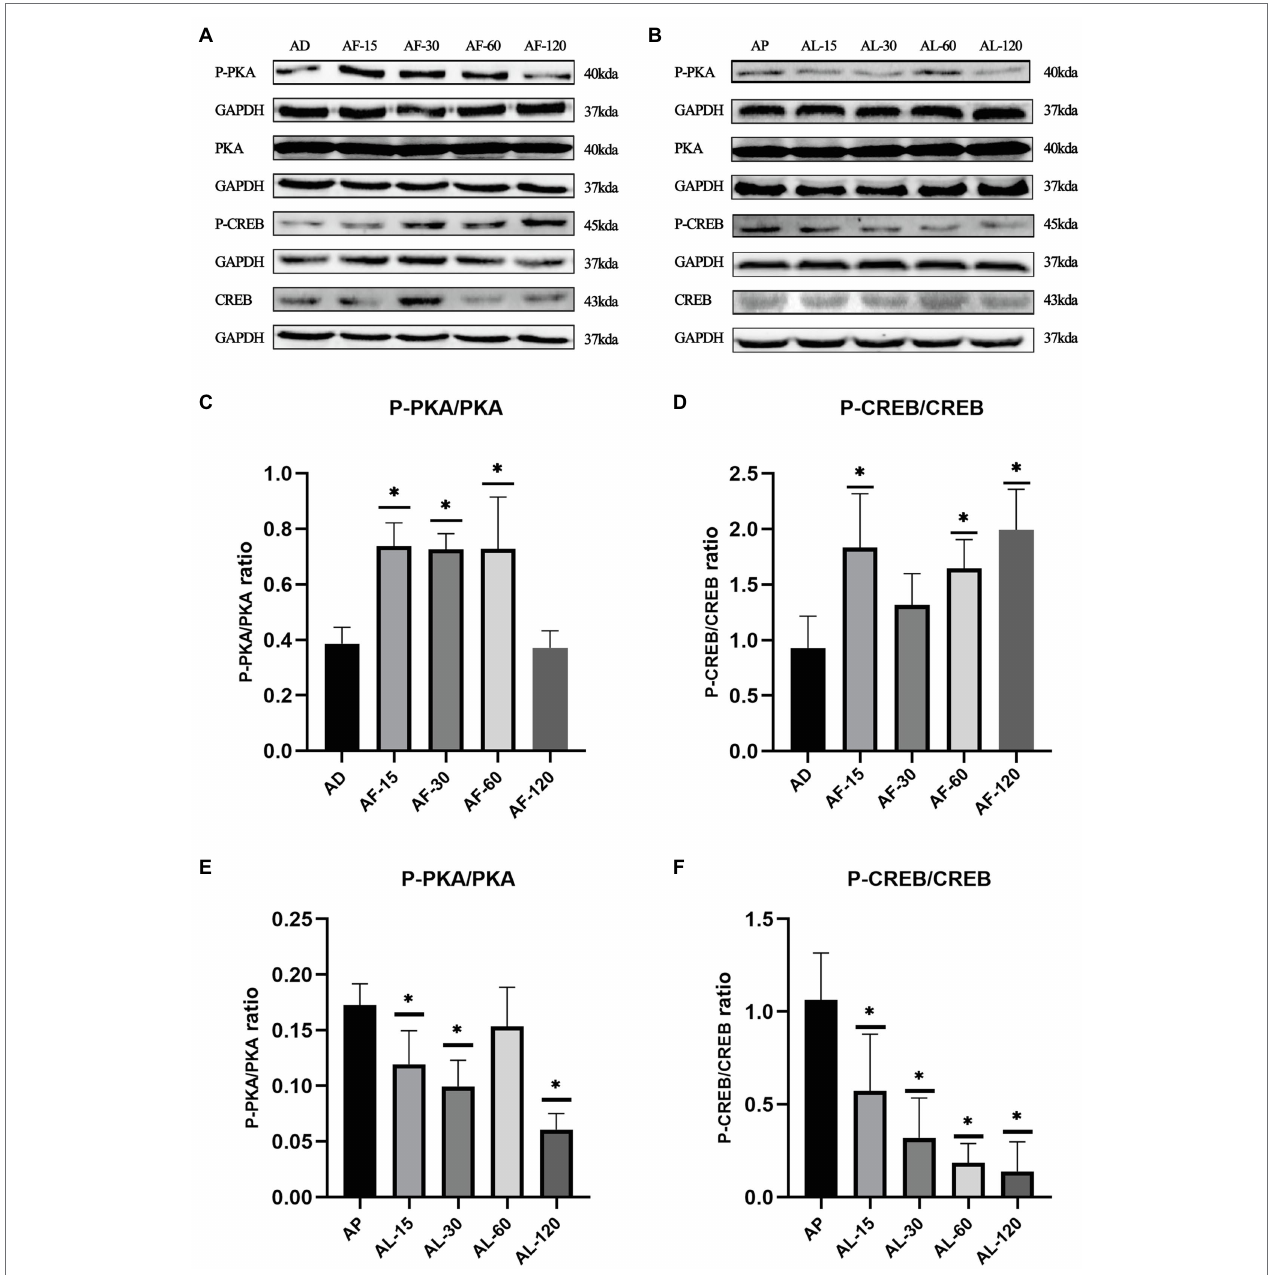
FIGURE 3 | The time-dependent effects of acute lactate and forskolin injection on the cAMP-PKA pathway. (A) Western blot analysis of cAMP-PKA pathway proteins after acute forskolin injection. (B) Western blot analysis of cAMP-PKA pathway proteins after acute lactate injection. (C,D) The ratios of P-PKA/PKA and P-CREB/CREB after acute forskolin injection. (E,F) The ratios of P-PKA/PKA and P-CREB/CREB after acute lactate injection. AL-15, AL-30, AL-60, and AL-120 represent 15, 30, 60, and 120 min after acute lactate injections. AF-15, AF-30, AF-60, and AF-120 represent 15, 30, 60, and 120 min after acute forskolin injections. AP and AD mean sacrificed after acute PBS and DMSO injection, respectively. Three bands are used for statistics. The data are presented as the mean ± SD, and significant differences between the two groups were analyzed with the independent-samples t -test. * p < 0.05 vs. AD and